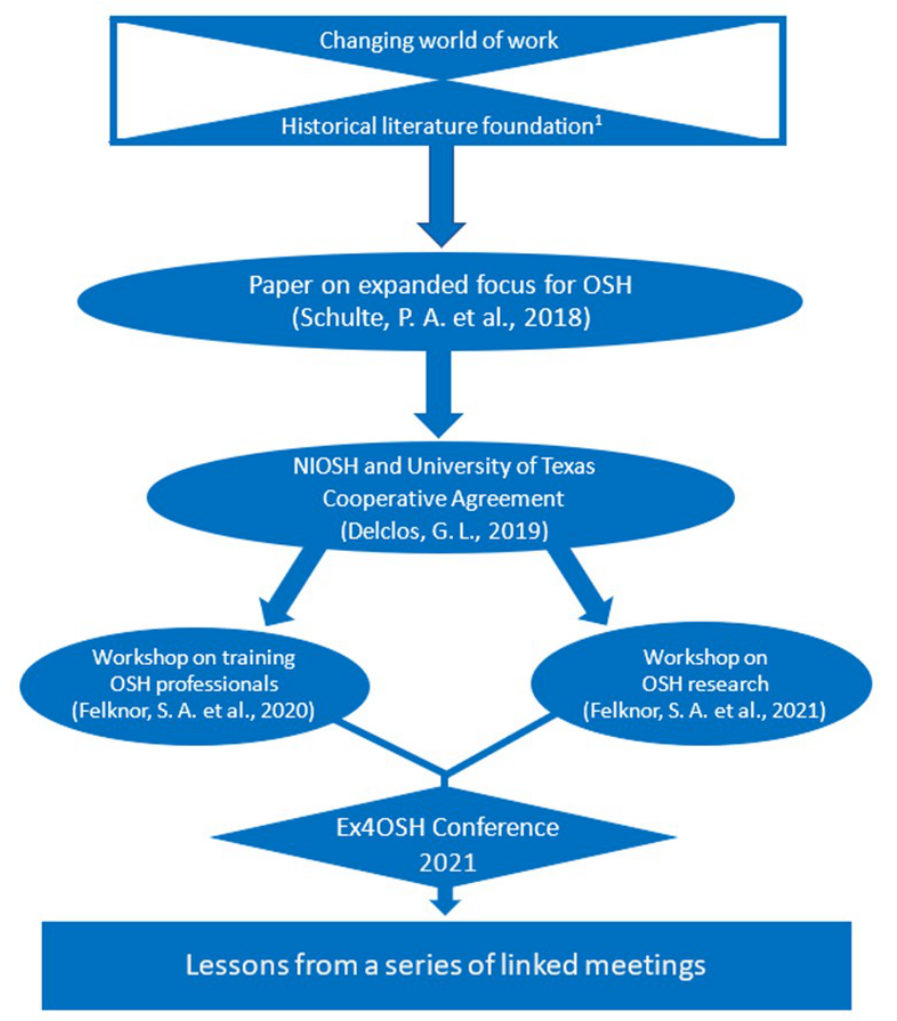
Figure 2. Overview of literature assessment and scientific meetings [18,19,76,114] ( 1 See Table S1 in Supplementary Materials for historical literature